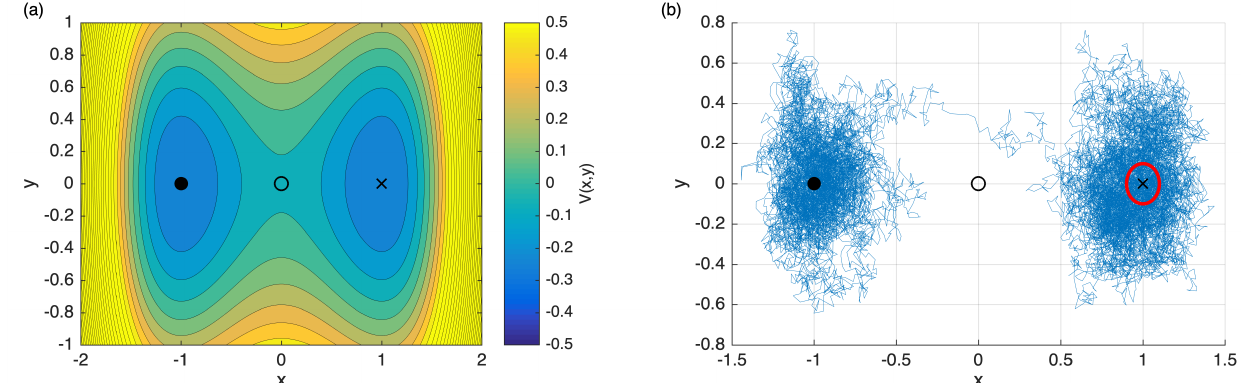
Figure 1. (a) Iso-potential contours corresponding to the double-well potential (Eq. 2). The two stable steady states X A = ( − 1 , 0 ) and X B = ( + 1 , 0 ) are marked with a filled circle and a cross, respectively. The saddle X C = ( 0 , 0 ) is indicated by a circle. (b) Example of a noise-induced transition from X A to X B for a particle moving in the double-well potential in (a) . The noise matrix in the general SDE (1) is chosen as G = σ I , with σ = 0 . 32. The red circle denotes an arbitrarily defined target set B .